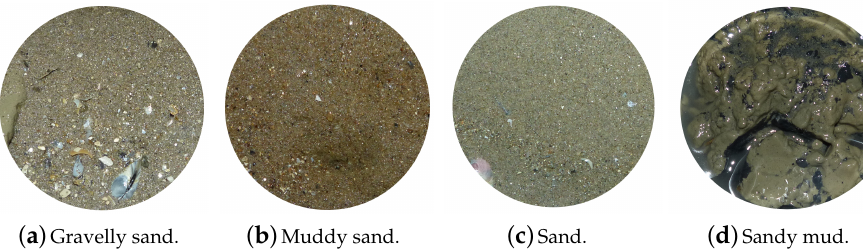
Figure 3. Photographic record of four sediment types.